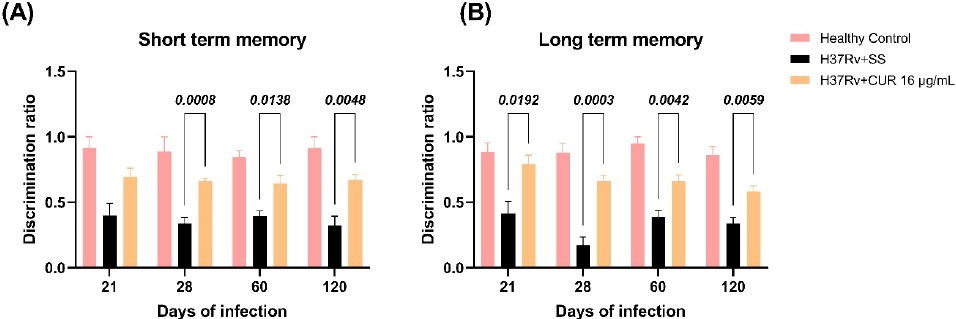
Figure 8. Effect of curcumin (CUR) treatment (16 μ g/mL) on TB mice’s memory damage. ( A ) Short- term memory of mice treated with CUR, control mice that only received saline solution (SS) as the vehicle, and healthy mice without infection. F (2, 15) = 77.03, p < 0.0001. Two-way ANOVA. Dun- nett’s multiple comparisons test. ( B ) Long-term memory of mice treated with CUR, control mice that only received SS as the vehicle, and healthy mice without infection. F (2, 12) = 86.60, p < 0.0001. Two-way ANOVA. Dunnett’s multiple comparisons test. Data are presented as mean ± SEM ( n = 6/day/group). Animals with TB treated with CUR showed a significant improvement in short-term memory from day 28 post-infection and long-term memory from day 21.